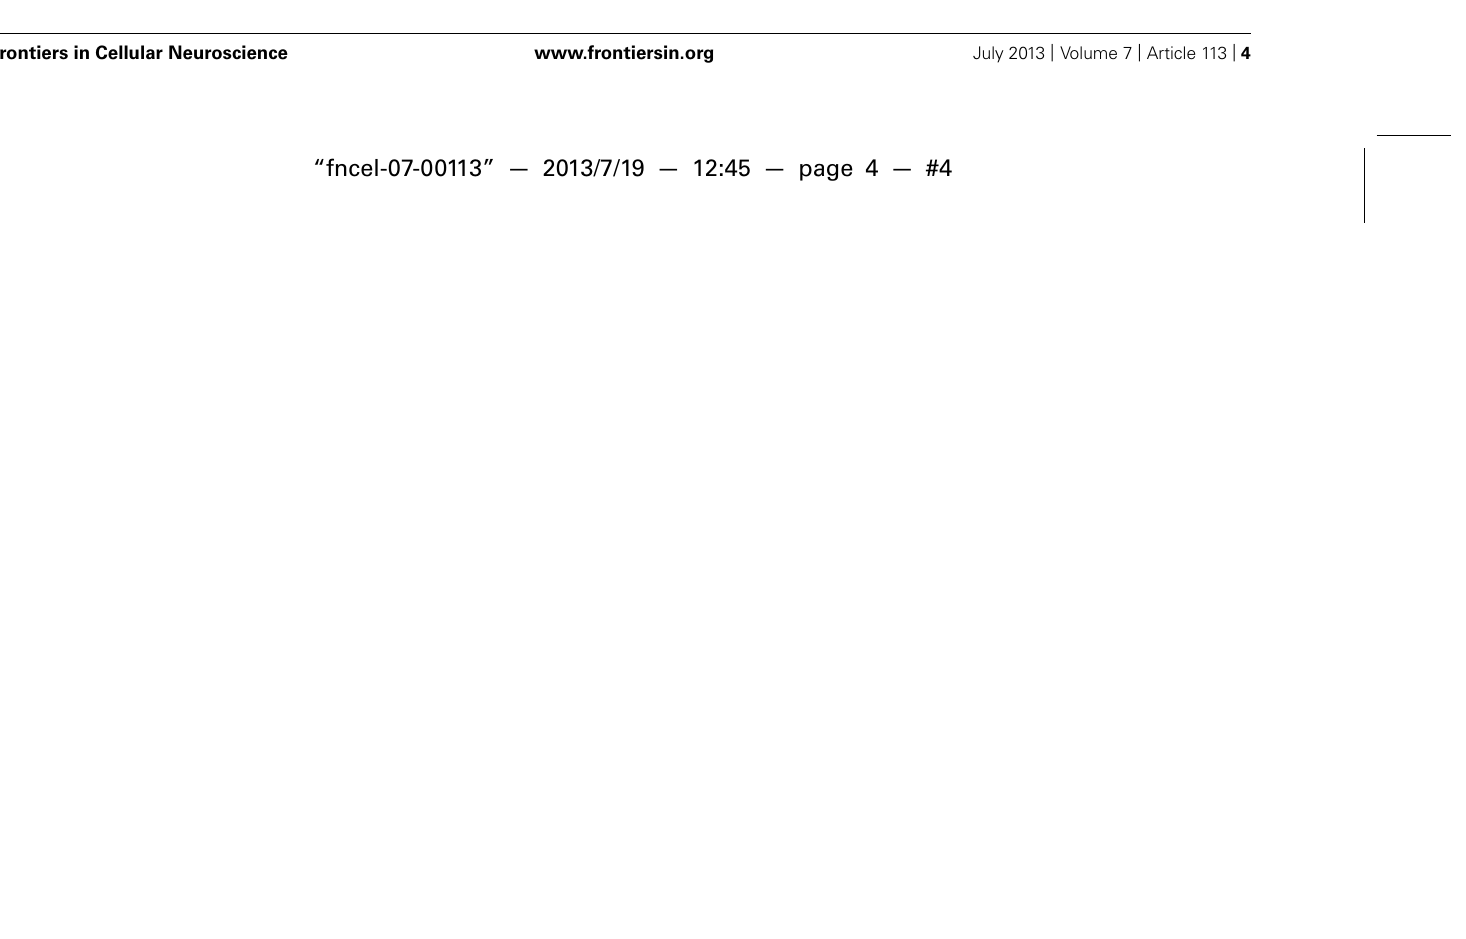
FIGURE 1 |Altered stability of GABA A R and scaffolding proteins during epileptogenesis. Induction of status epilepticus produces alterations in the expression of gephyrin and might disrupt GABA A R anchoring. Decreased expression of gephyrin might compromise the recycling of